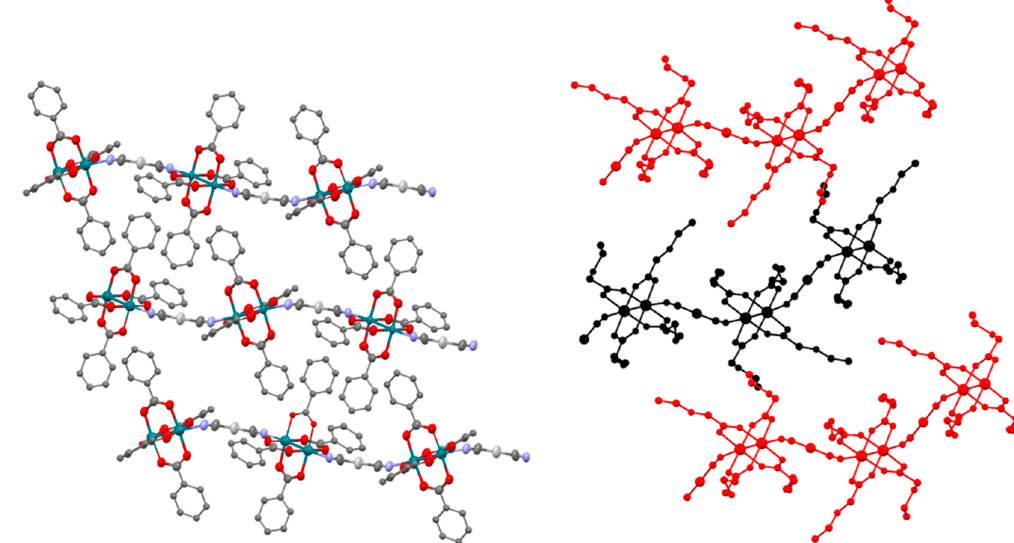
Figure 5. View of the chains that form 4 along the b axis ( left ). View of the chains that form 5 along the a axis. The chains are depicted in red and black colours for clarity ( right ). Hydrogen atoms are omitted for clarity.